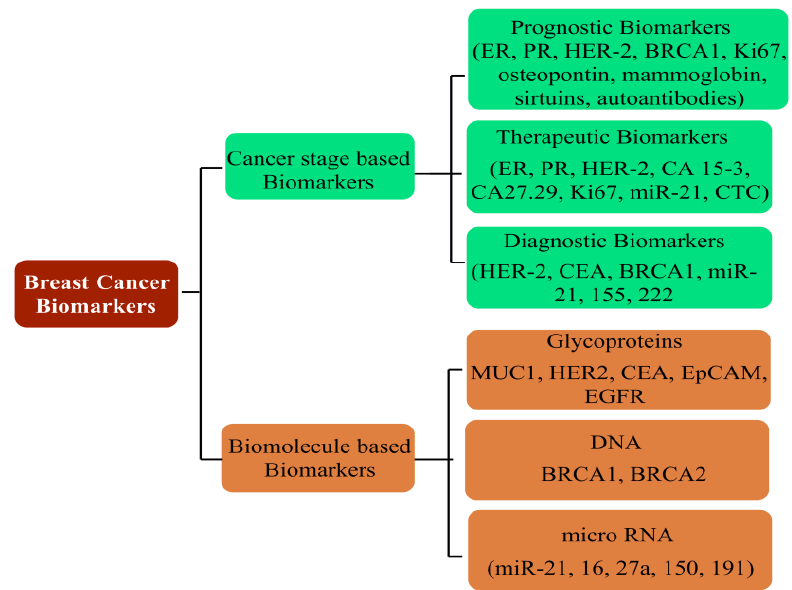
Figure 12. A summary of potential breast cancer markers diversified via (i) cancer-cell-stage-driven overexpressed surface markers and (ii) those which are expressed in conjugation with biomolecules. The former is rather more specific (exclusive to BC), while biomolecule-based markers are more reliable as therapeutic targets.